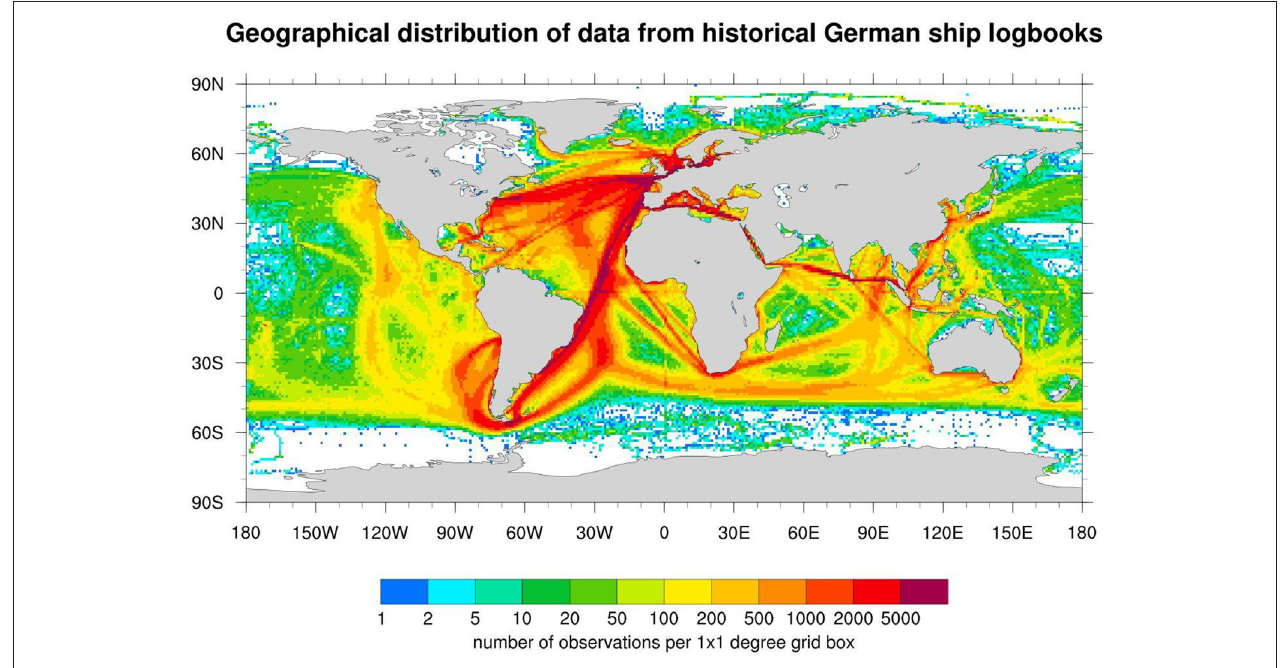
FIGURE 5 | Geographical distribution of observations from historical ship logbooks digitized by Deutscher Wetterdienst (Status: 2021).